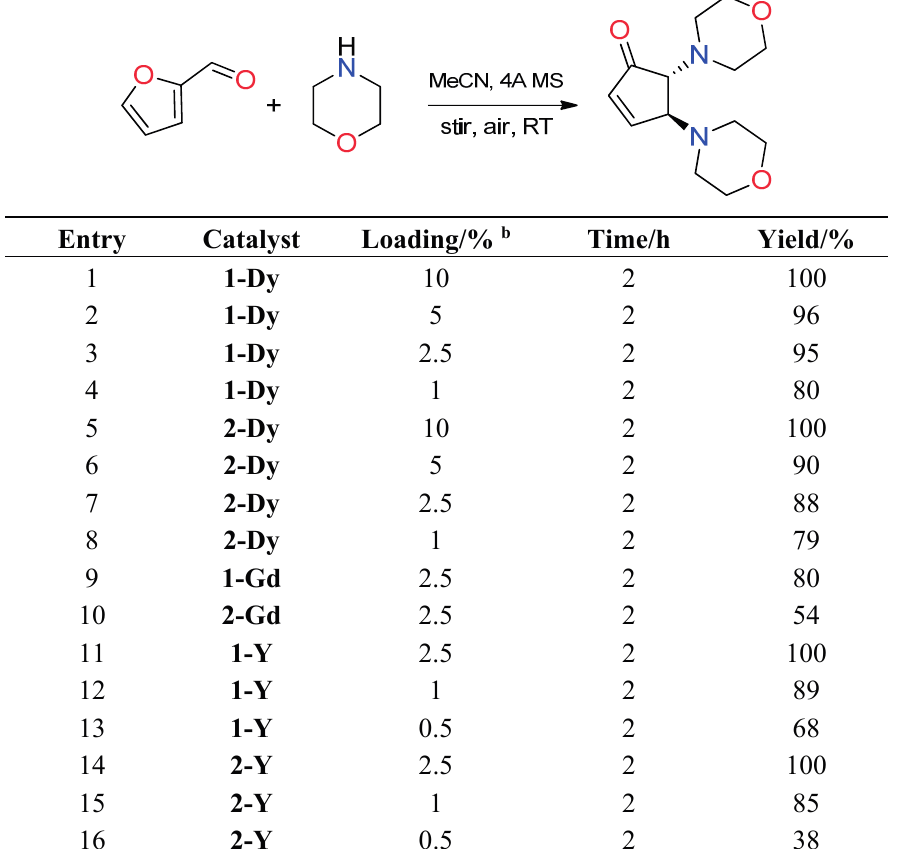
Table 1. Comparison of catalytic activity for compounds 1-Dy , 2-Dy , 1-Gd , 2-Gd , 1-Y and 2-Y a